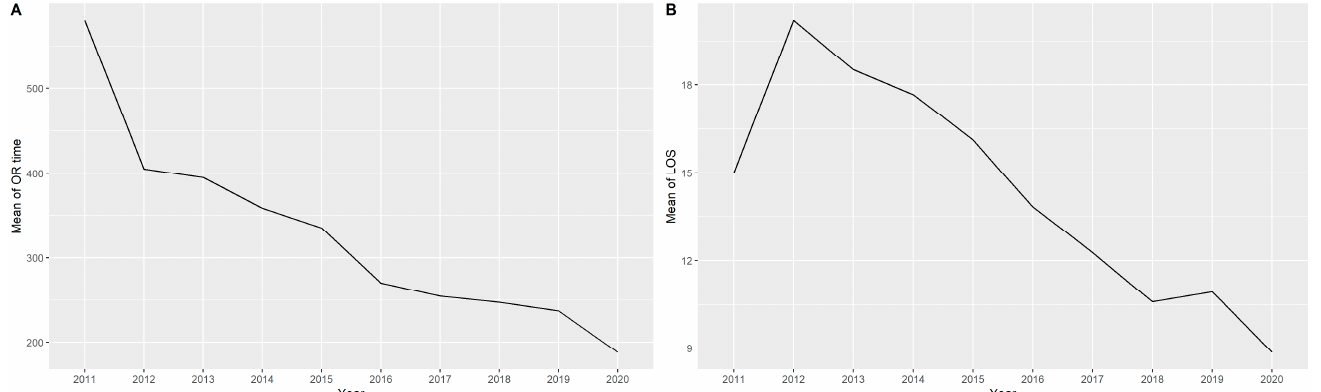
Figure 1. ( A ) Historical trend of operation time. ( B ) Historical trend of length of stay.